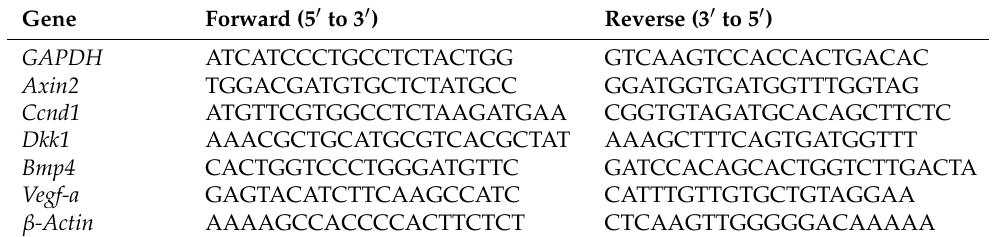
Table 1. The primer pairs list for